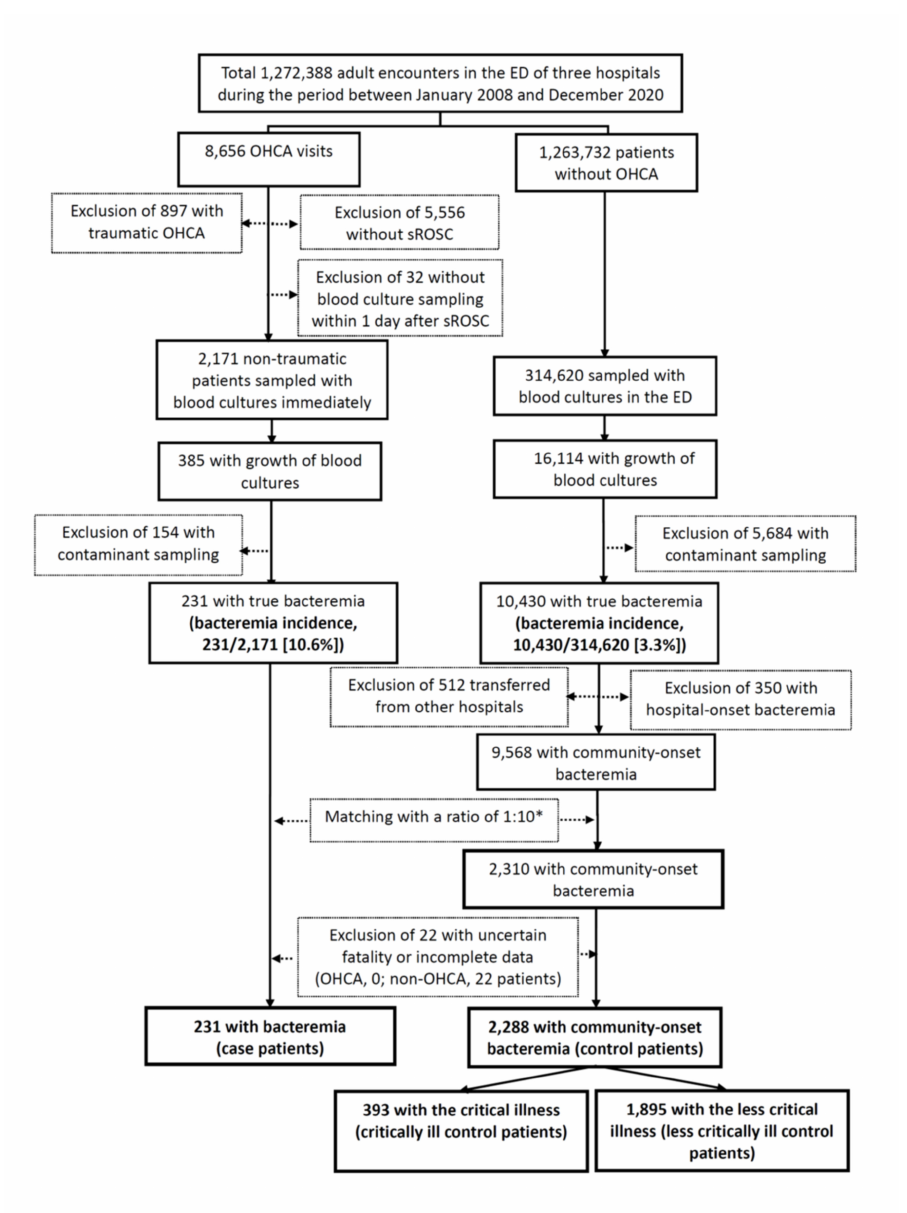
Figure 1. Flowchart of patient selections. BC = blood culture; ED = emergency department; OHCA = out-of-hospital cardiac arrest; sROSC = sustained return of spontaneous circulation. * Ten non-OHCA patients temporally near ED arrival of each OHCA visit were matched. Of 231 case patients, their median (interquartile range (IQR)) age was 73 (57–82)